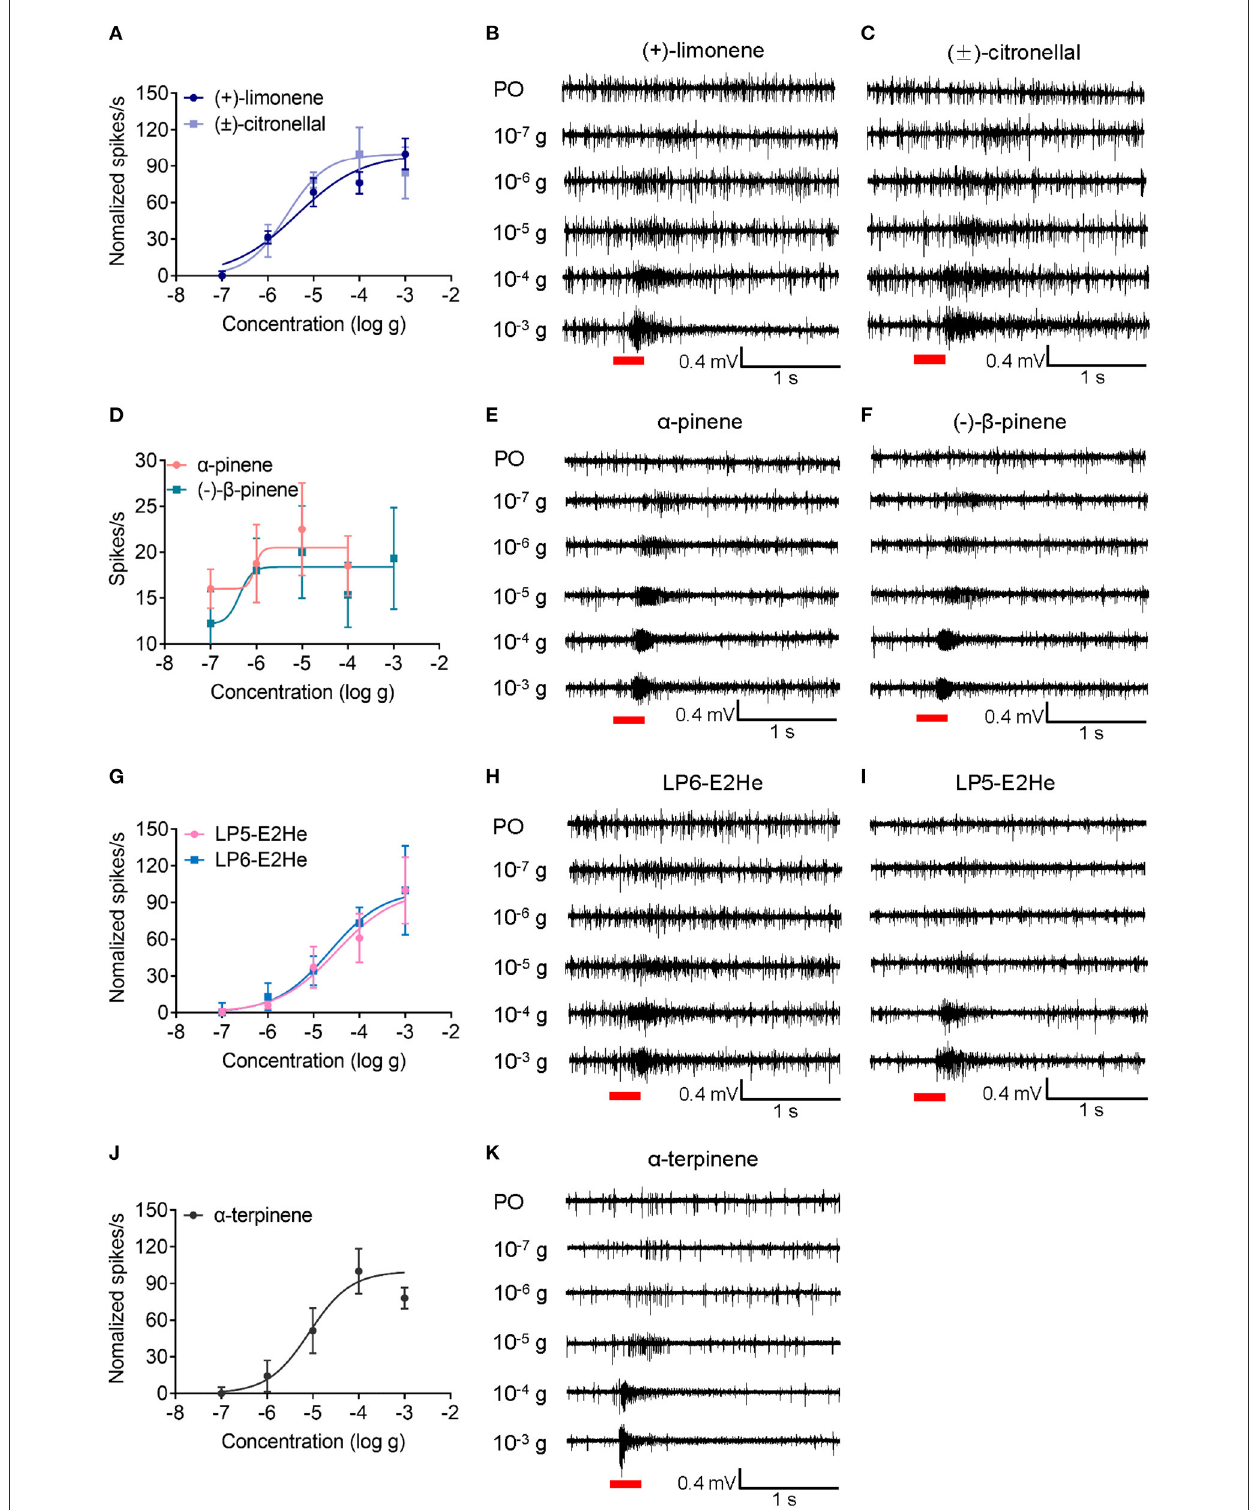
FIGURE6 Excitatory dose-dependent responses of ORNs in placoid sensilla of C. cedri to the tested odorants. (A) Dose-response curves of ORNs in LP6 to ( + )-limonene and ( ± )-citronellal across a range of doses from 10 − 7 to 10 − 3 g. The EC 50 values induced by ( + )-limonene and ( ± )-citronellal are 4.31 × 10 − 6 g ( n = 4) and 2.62 × 10 − 6 g ( n = 4), respectively. (B, C) SSR traces showing ORNs were activated by ( + )-limonene and ( ± )-citronellal. (D) Dose-response curves of ORNs in LP5I to α -pinene and (–)- β -pinene with EC 50 values of 1.10 × 10 − 6 g ( n = 4) and 8.40 × 10 − 7 g ( n = 4), respectively. (E, F) SSR traces showing ORNs were activated by α -pinene and (–)- β -pinene. (G) Dose-response curves of ORNs in LP5I and LP6 to trans -2-hexenal with EC 50 values of 3.13 × 10 − 5 g ( n = 4) and 2.24 × 10 − 5 g ( n = 4), respectively. (H, I) SSR traces showing ORNs in LP6 and LP5I were activated